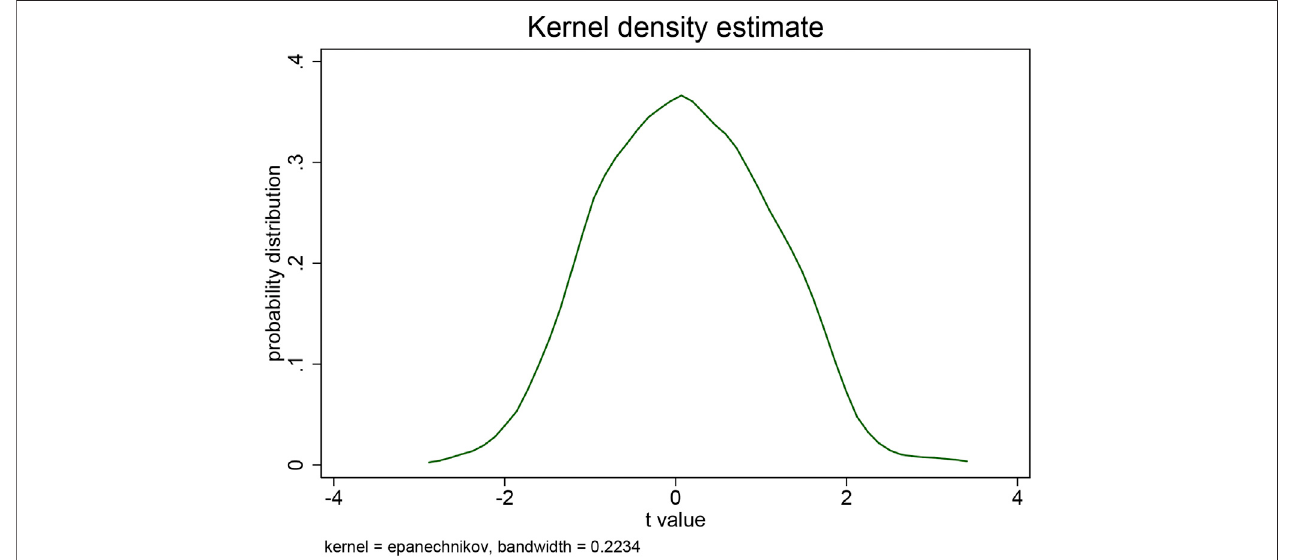
FIGURE 2 | Placebo test kernel density